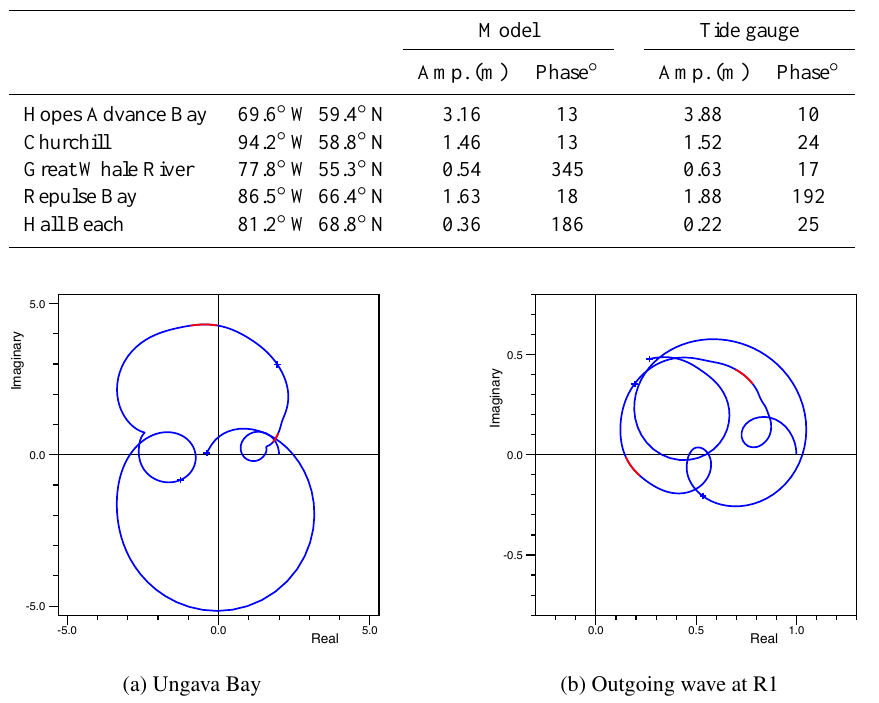
Figure 4. Real and imaginary components of (a) the response function on the west side of Ungava Bay and (b) the outgoing wave at point R1 on the open boundary, plotted for real values of angular velocity between zero and 30 rad / day . Crosses at intervals of 10 rad / day . The red sections correspond to the diurnal and semi-diurnal tides. At zero rad / day the response function at Ungava Bay has the value (2+ i 0) and the outgoing wave has the value (1+ i 0) .